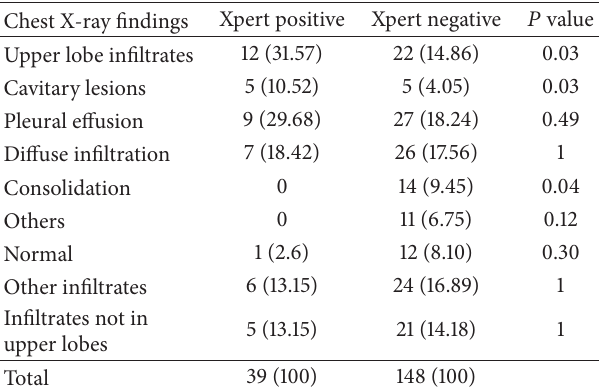
Table 2: Comparison of chest X-ray features of 187 patients testing positive or negative by